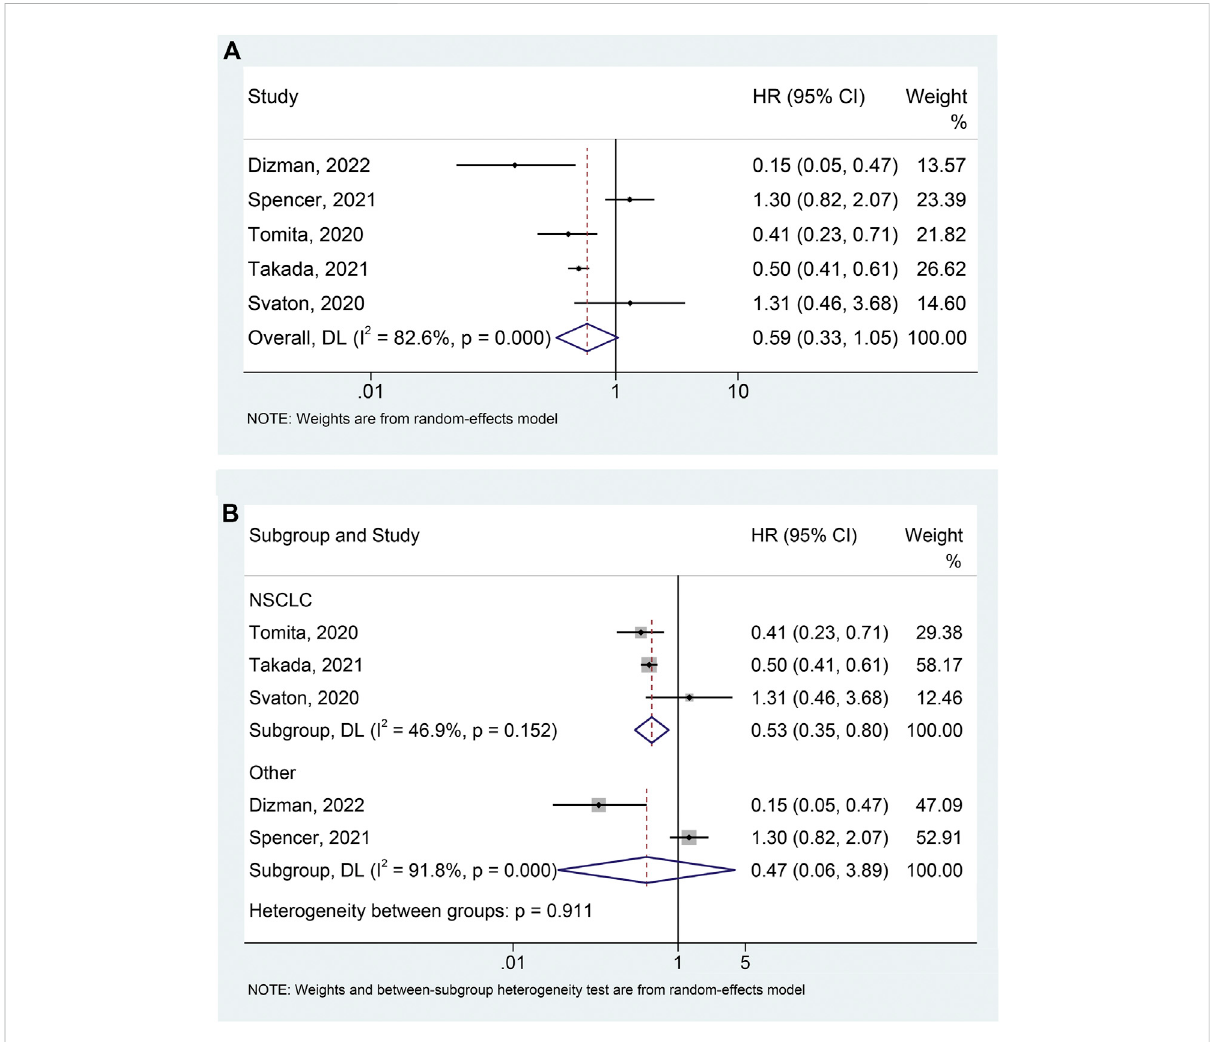
FIGURE 2 Forest plots of HR for correlation of probiotic administration with progression-free survival (A) . Subgroup analysis of progression-free survival based on cancer types (B) . NSCLC, non-small cell lung cancer; HR, hazard ratio; CL, con fi dence interval; Univariate analysis (Dizman et al., 2022); Multivariable analysis (Svaton et al., 2020; Tomita et al., 2020; Spencer et al., 2021; Takada et al.,